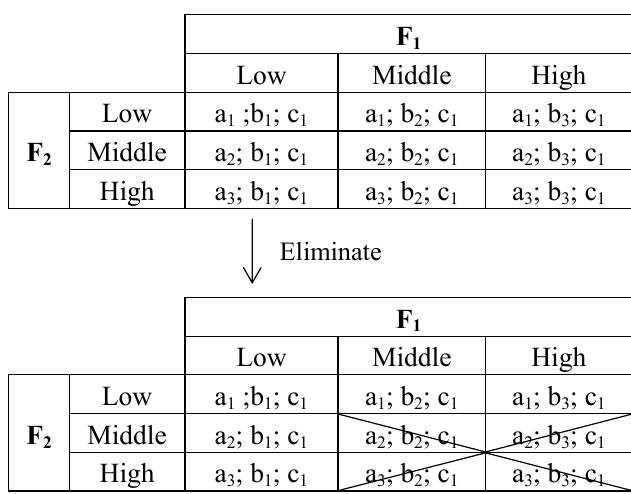
Table 4. Iterated Elimination of Strictly Dominant Strategies.